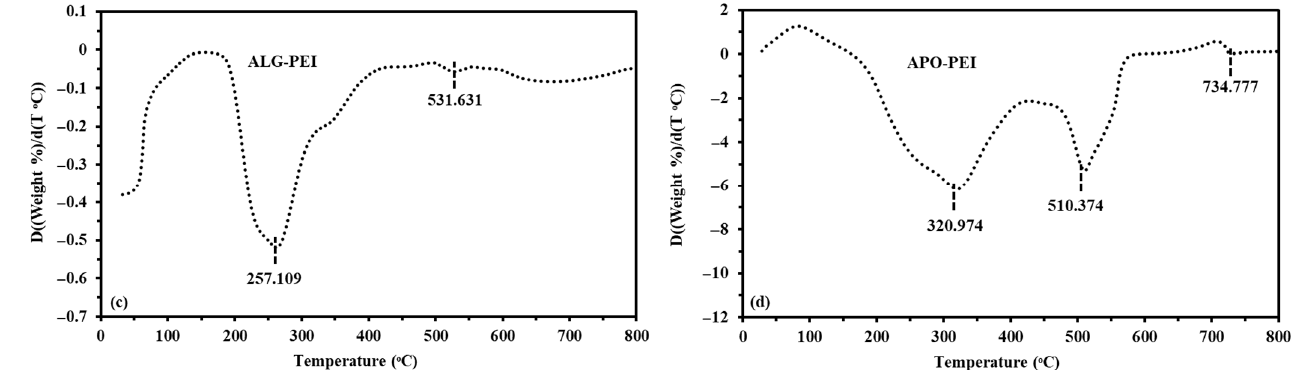
Figure A3. Characterization of thermal degradation of ALG-PEI ( a , c ) and APO-PEI sorbents ( b , d ): TGA curves (weight loss, a , b ) and DTG curves ( c , d ).